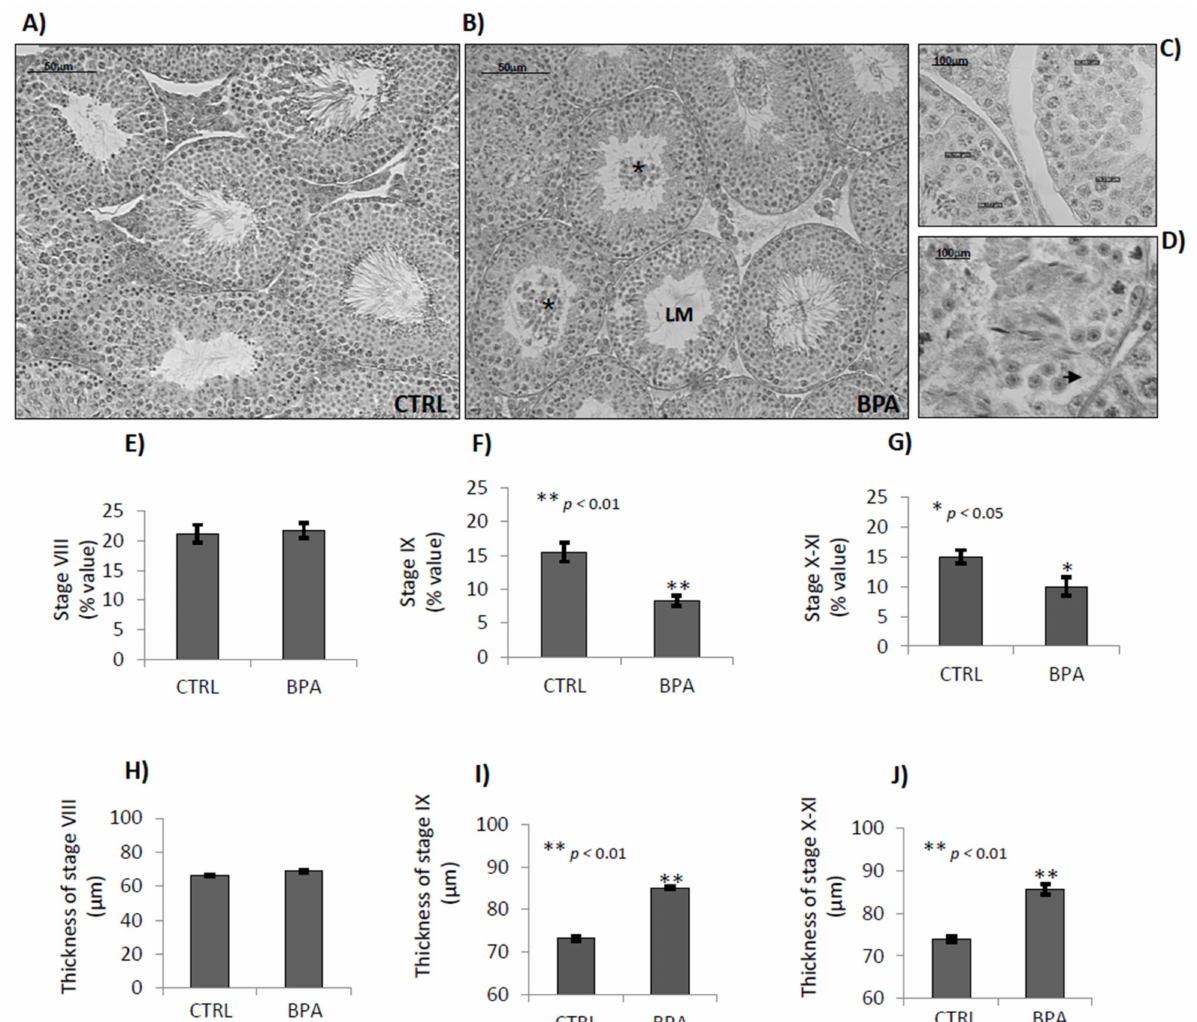
Figure 6. Histological analysis of seminiferous tubules from male mice early-life exposed to vehicle (CTRL) or BPA and sacrificed at 78 dpp . Representative H&E stained sections of testis from CTRL ( A ), or BPA ( B – D ). LM: Lumen; * : lumen filled with detached germ cells; Arrow: cytoplasma retraction of Sertoli cells (scale bar: 50 µ m; inset scale bar: 100 µ m). Number of stages VIII ( E ), IX ( F ) and X–XI ( G ) relatively to total tubules (% values). Thickness of seminiferous epitelium ( µ m) of stage VIII ( H ), IX ( I ) and X–XI ( J ) tubules. All the data were reported as mean values ± S.E.M. (*: p < 0.05; **: p <